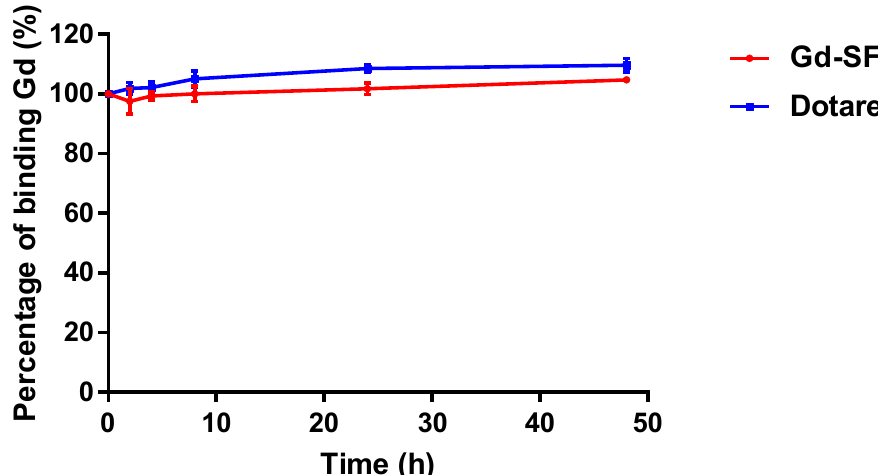
Figure 4. Gd(III) content in Gd-DOTA-click-SF and Dotarem at different time points of incubation in PBS buffer and ZnCl 2 (250 mM).